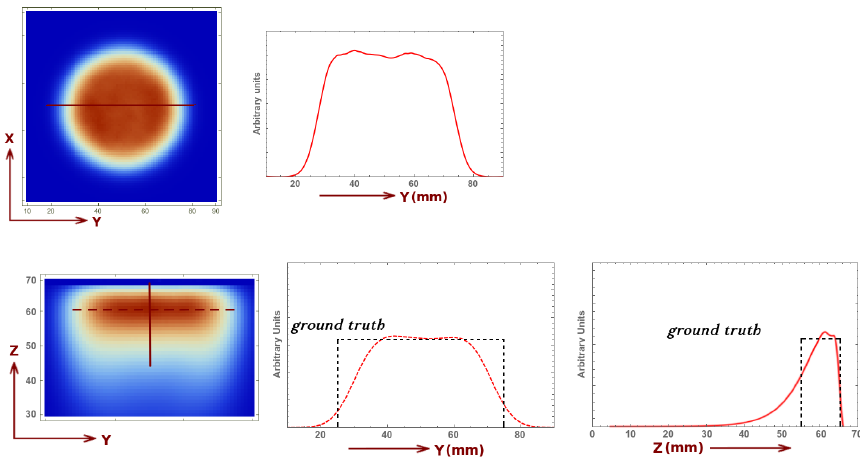
Figure 7. Image reconstruction of the uniformity phantom and its corresponding profile in the x , y plane ( top ) and the y , z plane ( bottom ). The ground truth profile is also shown for the last case (see reference system defined in Figure